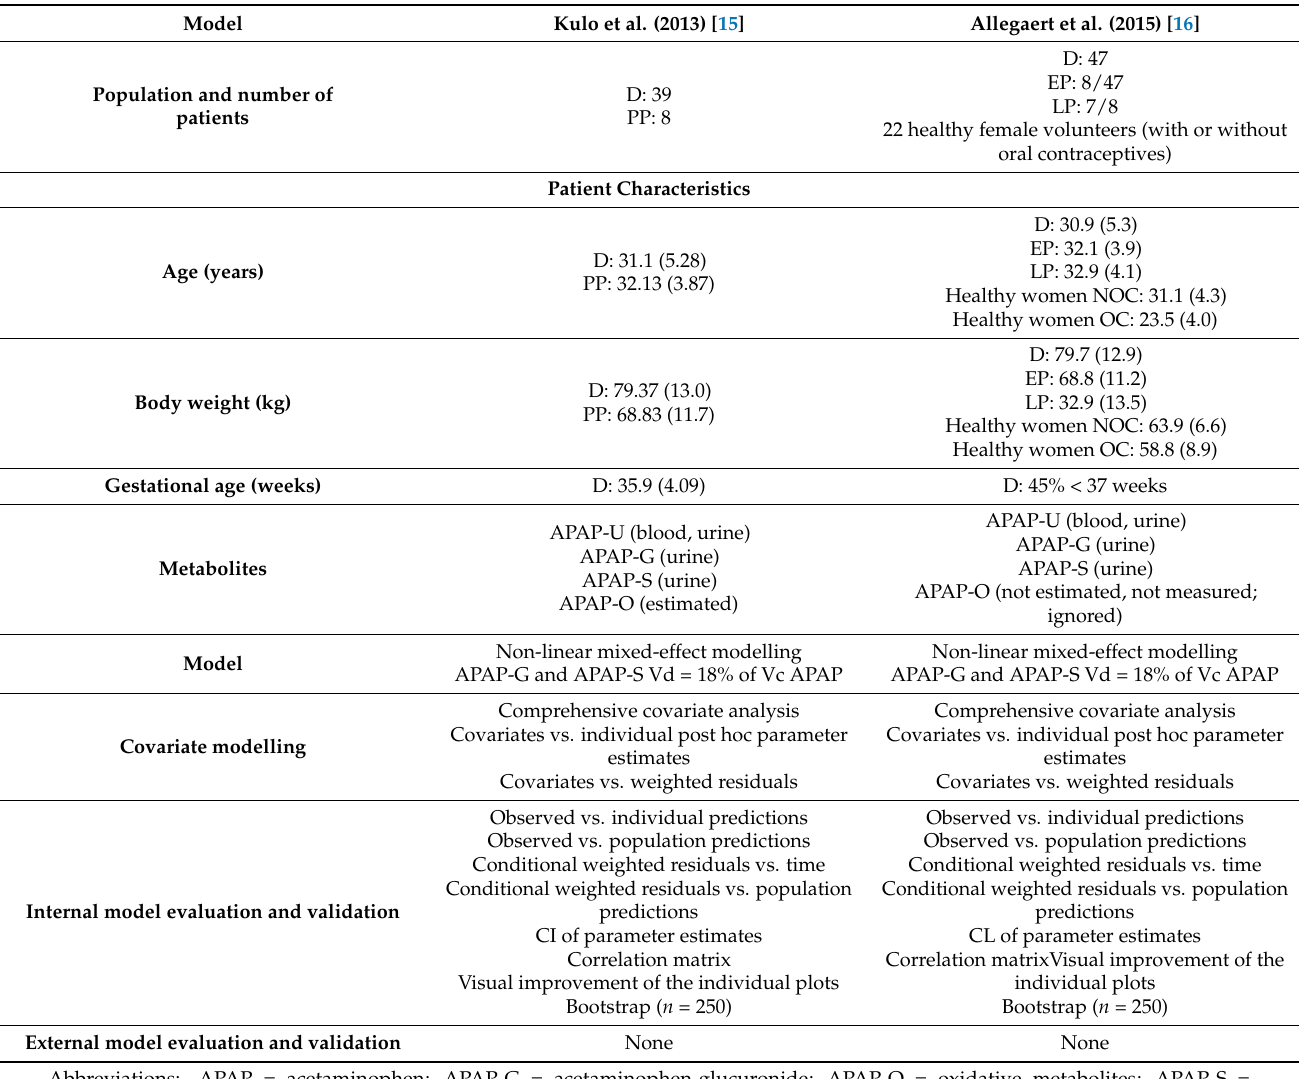
Table 5. Details of the population PK models on acetaminophen in pregnancy. Data shown as mean (SD). Model